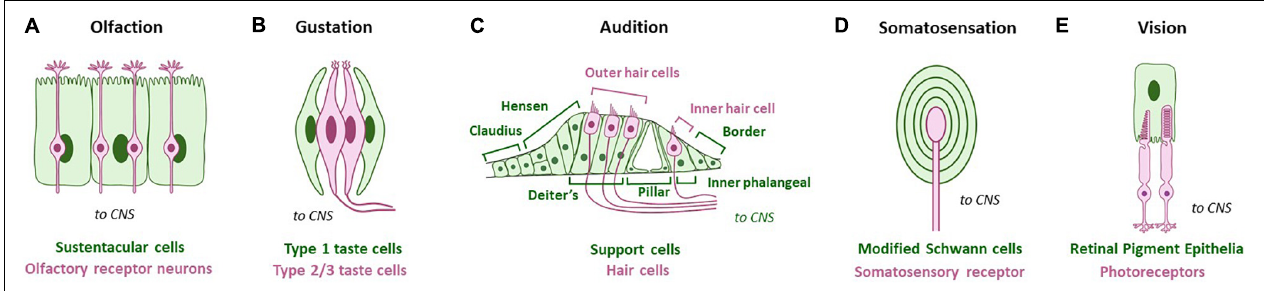
FIGURE 1 | Glia-like support cells at mammalian peripheral sense organs across modalities. Green cells/text are support cells, while magenta cells/text are sensory cells. (A) Olfaction: Sustentacular cells appose olfactory receptor neurons. (B) Gustation: Type I glia-like cells contact Type II and Type III receptor cells in vertebrate taste buds. (C) Audition: Deiter’s support cells interact closely with outer hair cells, and inner phalangeal support cells interact closely with the inner hair cell. Other support cells are also noted. (D) Somatosensation: Somatosensory receptors are surrounded by modified Schwann glia cell lamellae. Pacinian corpuscles are shown